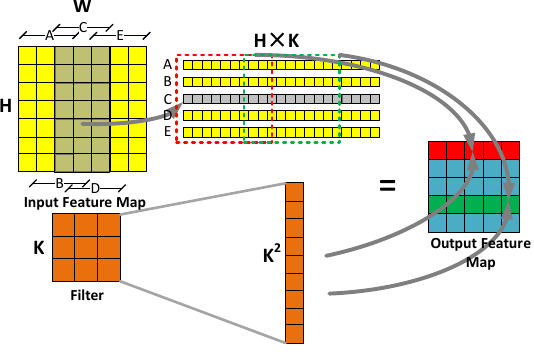
Figure 3. Calculation process of MEC.